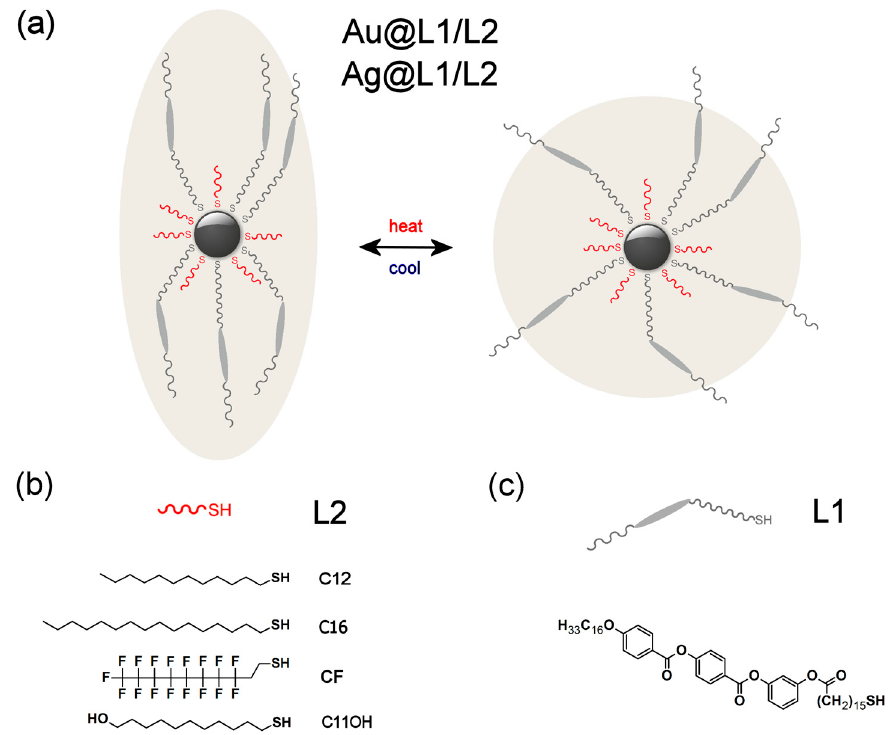
Figure 1. Structure of hybrid silver nanoparticles. ( a ) Schematic model of Au@L1/L2 and Ag@L1/L2 nanoparticles showing thermally driven nanoparticle reshaping resulting from ligand spatial arrangement around nanocrystal core. Limited number of ligands is shown for clarity. Sizes of ligands and nanocrystal core are not to scale. ( b ) Structure of alkyl co-ligands used in the study. ( c ) Structure of the L1 ligand.